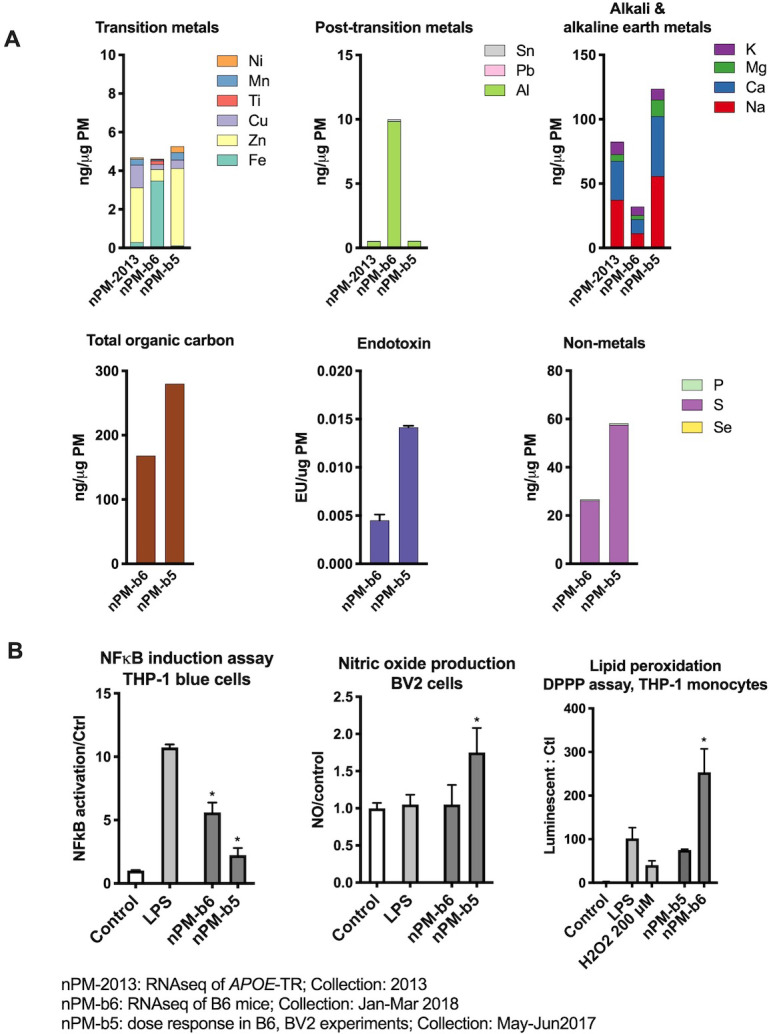
Chemical characterization (A) and cellular activity (B) of nPM batches collected after 2017 in this study.The batch IDs (nPM-b) correspond to our analysis of nPM chemistry from batches collected after 2016 (Zhang et al., 2019). The APOE-TR exposure was done during Feb-May 2013, for which chemical characterization is not available. Representative annual value for nPM-2013 metal content is shown, which was comparable with nPM-b5.